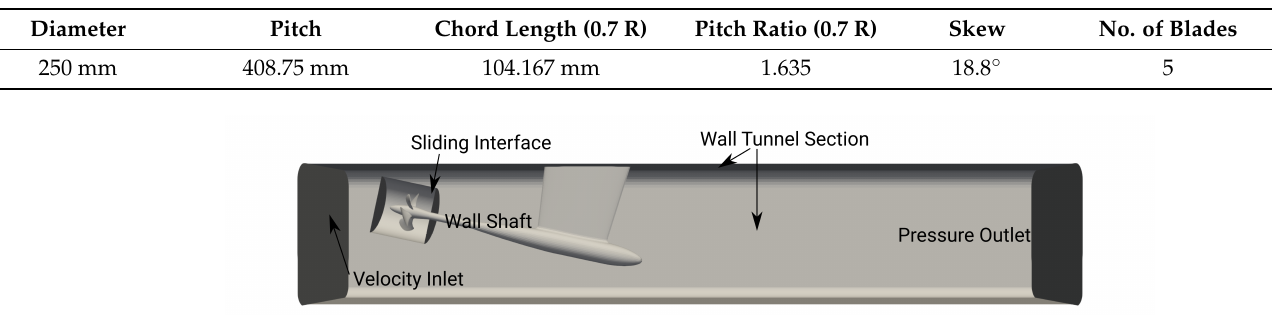
Table 3. Main characteristics of propeller VP1304.